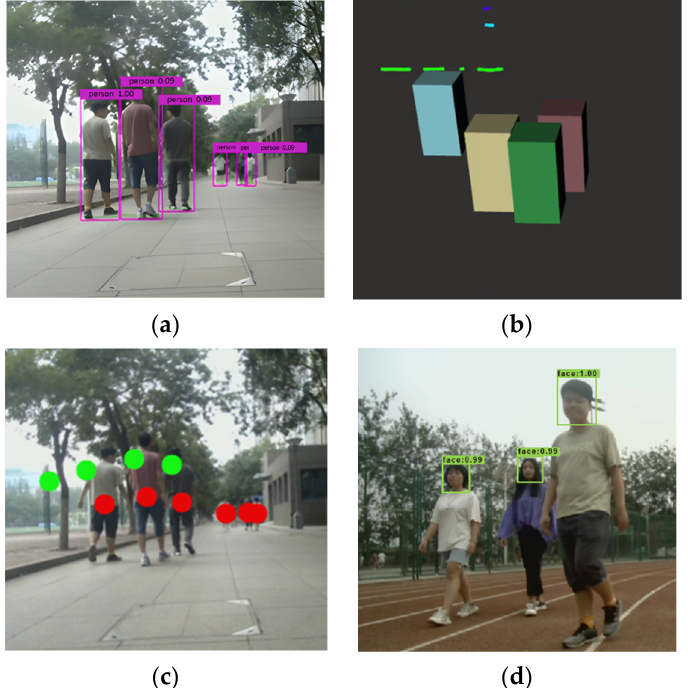
Figure 12. The results of pedestrian detection and face detection. ( a ) 2D detction box. ( b ) 3D detection box. ( c ) Fusion results. ( d ) Face detection results. box. ( c ) Fusion results. ( d ) Face detection